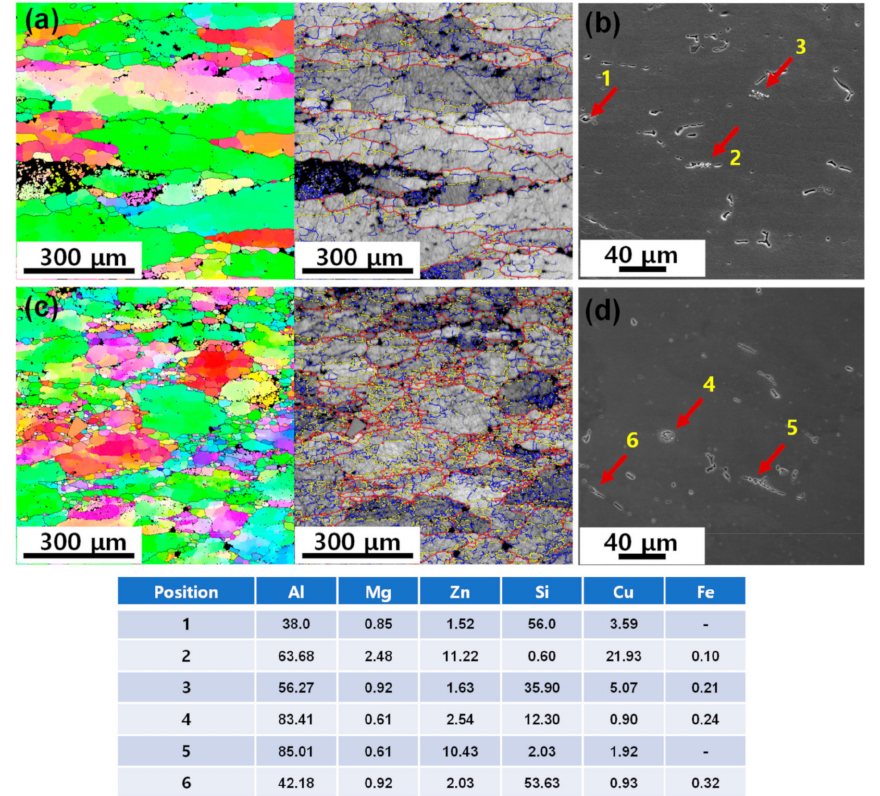
Figure 12. The IPF and GB maps of the ( a ) as-cast and ( c ) extruded alloys after compression tests at 723 K–10 − 3 s − 1 . The SEM micrographs of the ( b ) as-cast and ( d ) extruded alloys after compression tests at 723 K–10 − 3 s − 1 . The inserted table represents the EDS analysis